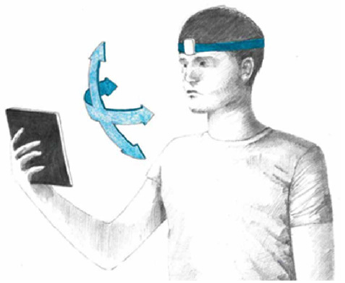
Figure 2. Experimental set-up used for Gym and Read exercises. To perform the other two exercises ( Touch and Memory ), the child did not need any head movement detection. The four exercises were randomly presented to the child. In the Gym exercise, the child had to rotate his head to the right, left, up or down randomly, as requested by the program. The child fixed a central dot (1 cm), and afterwards he moved his head initially at 80 ◦ /s (Figure 3(1)). If the head movement was not sufficiently wide, a head with arrows appeared to explain to the child the type of movement that needed to be done (Figure 3(2)). If the head movement was too fast, a hare appeared on the screen indicating to the child that he had to move his head slowly (Figure 3(3)). In both cases, the child had to do a head movement until he reached the corrected head speed. When the head movement was correctly done, a number (1 cm) appeared in the middle of the screen for 120 ms (Figure 3(4)). Afterwards, the child was invited to select the number seen on the list of numbers seen on the bottom of the tablet; the child had 10 s to answer. As the level increased, the head velocity increased (from 80 deg/s to 150 deg/s). In the Read exercise, the child had to make rotations of the head to the right and left on the longitudinal body axis only. The program was similar to those of the Gym exercise, but instead of a simple number the child had to read a word of 3 letters (0.5 cm each) that appeared on the screen for 200 ms. The child had to remember the sequence of letters and select the same sequence seen among five that were displayed on the bottom of the tablet. As the level increased, the number of letters